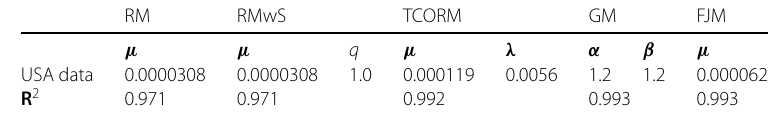
Table 1 Fitting parameters for the USA commuting data, considering the models given by equations (6), (7), (8), (3) and (16). The R 2 values and fitted curves suggests that the FJM and GM models performs better than the simple RM, RMwS, or TCORM model. For the FJM model a = 7/4 was fixed